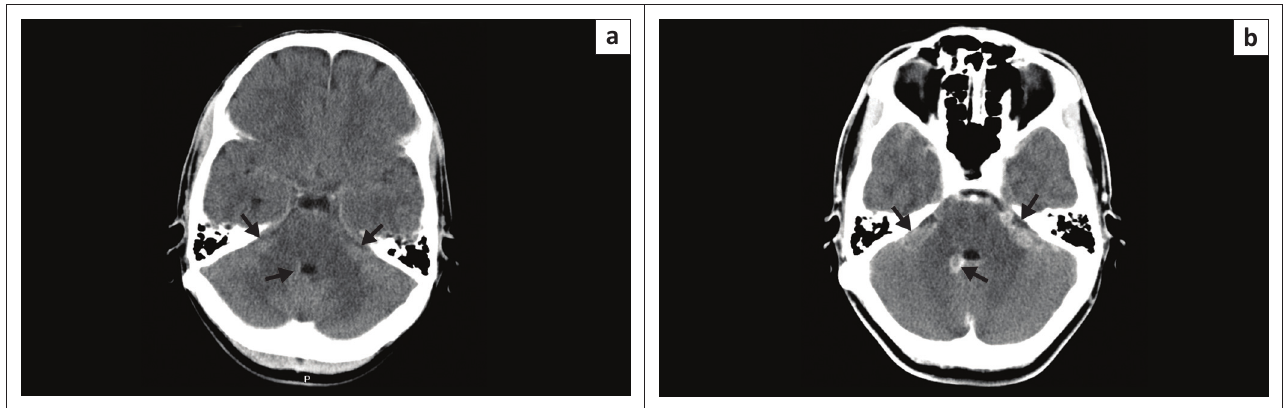
NECT, non-contrast-enhanced computed tomography; CECT, contrast-enhanced computed tomography. FIGURE 2: (a) NECT and (b) CECT of the cerebellum. Multiple enhancing nodules seen in the CP angle and to the right of the fourth ventricle on the CECT (b, arrows). These nodules are vaguely visible on the NECT (a, arrows) but were missed by the reviewers.